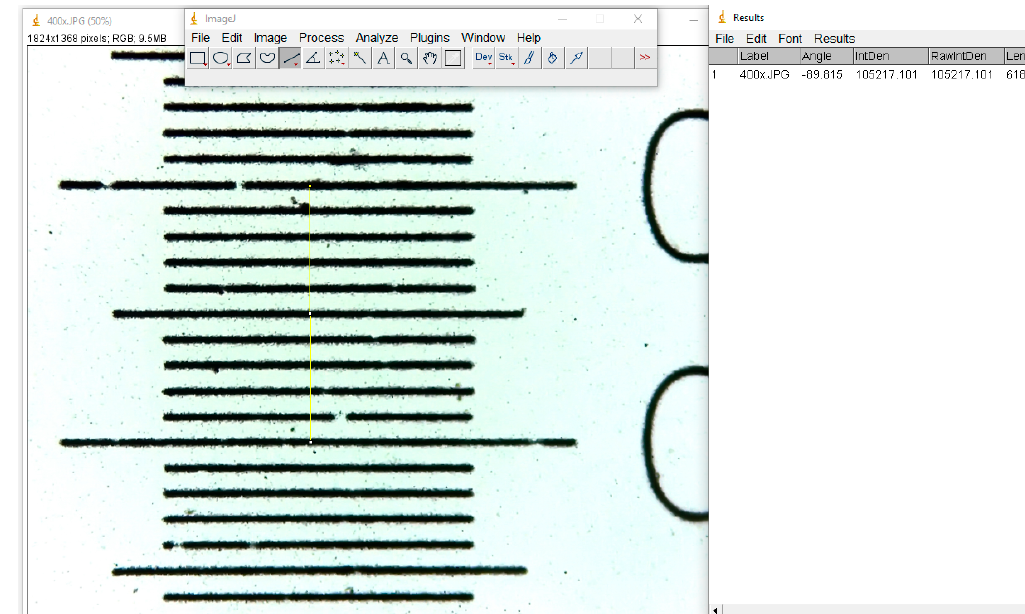
Figure 2. Measurement calibration in ImageJ with a micrometric grid.